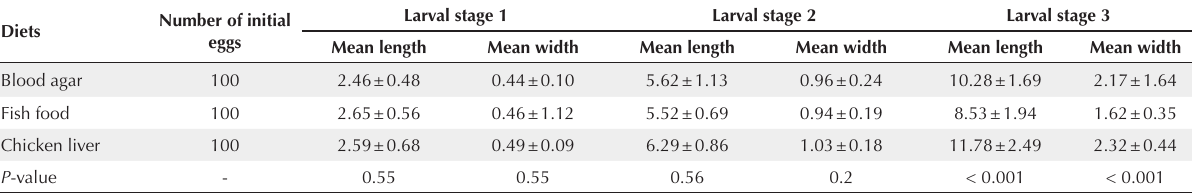
Table 1. The Results of the Length and Width Measurements (millimeter) of Different Growth Stages of L. sericata in All Repetition of Diets Diets